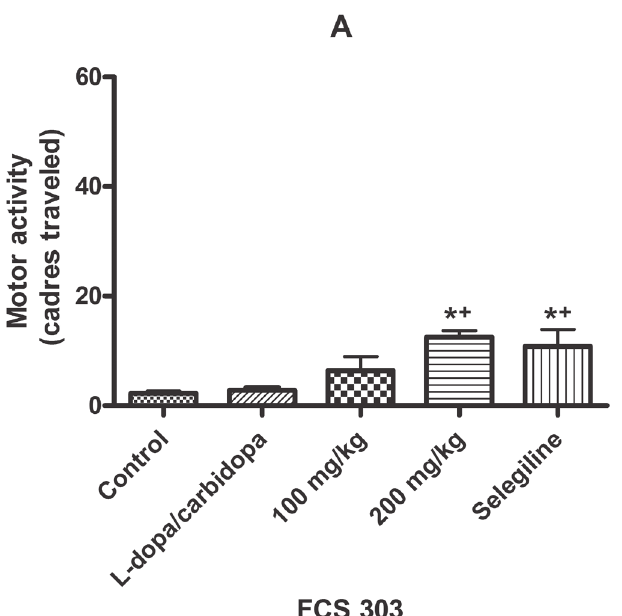
FIGURE 4A - Effect of administration of levodopa/carbidopa (100/10 mg/kg) plus FCS303 (100 and 200 mg/kg), control (vehicle 0.1 mL/10 g body weight), or selegiline (10 mg/kg) on motor activity in mice pre-treated with reserpine (3 mg/kg).